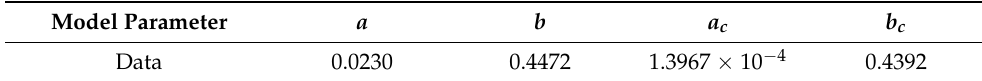
Table 1. Multi-stage prediction model